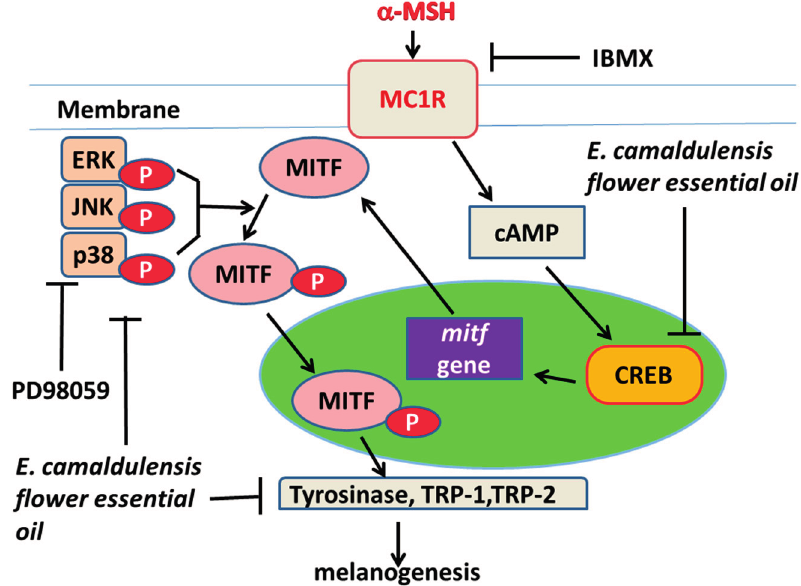
Figure 6. E. camaldulensis flower essential oil regulates melanin synthesis signaling